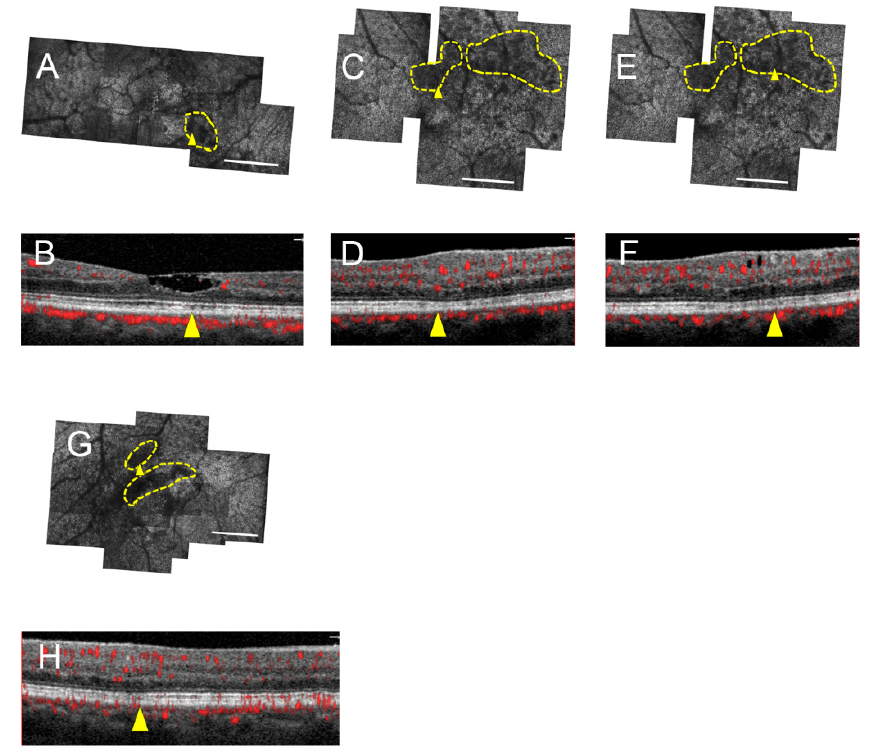
Figure 4. Comparison of AOSLO and SD-OCT cross-sections reveals photoreceptor lesions corresponding to intact EZ with either attenuated or absent IZ. Subjects 2 (left eye; A , B ), 4 (left eye; C – F ), and 7 (right eye; G , H ). AOSLO montages with outlined, yellow lesion and yellow arrowhead ( A , C , E , G ) corresponding to accompanying SD-OCT cross-sections ( B , D , F , H ). IZ appears attenuated in ( B ) but absent in ( D , F , H ). Scale bars = 500 μ m.